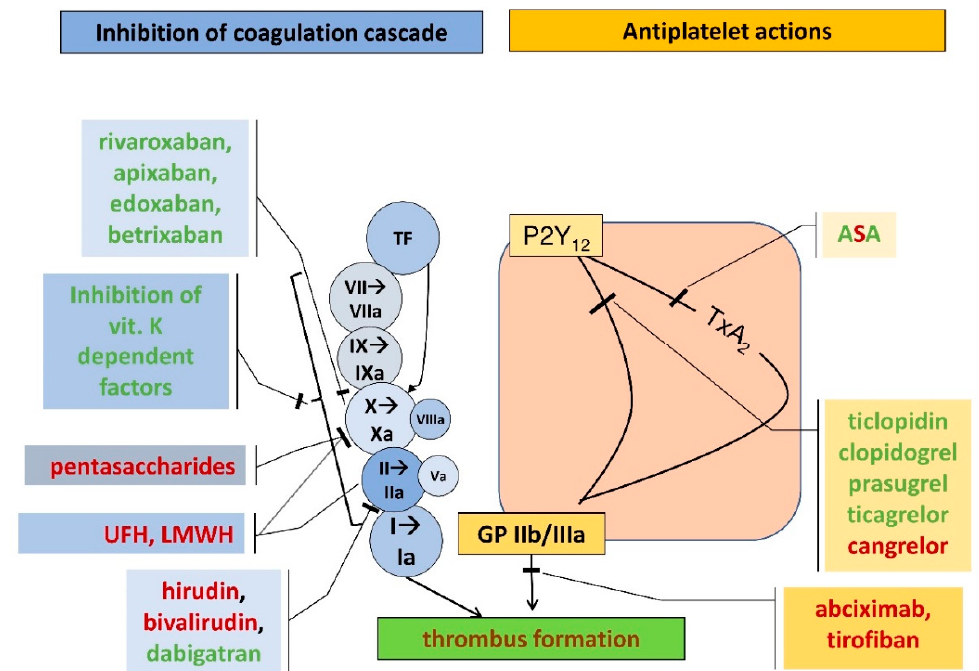
Figure 3. Coagulation cascade (blue rectangles and circles) and the action points of various anticoagulants and antiplatelet agents (yellow rectangles) (UFH, unfractionated heparin; LMWH, low-molecular weight heparin; TF, tissue factor; ASA, acetylsalicylic acid; P2Y 12 , receptor for endogenous nucleotides type 12, TxA 2 , thromboxane A 2 , GP IIb/IIIa, glycoprotein IIb/IIIa). Route of administration: red font—parenteral forms, green font—oral agents.